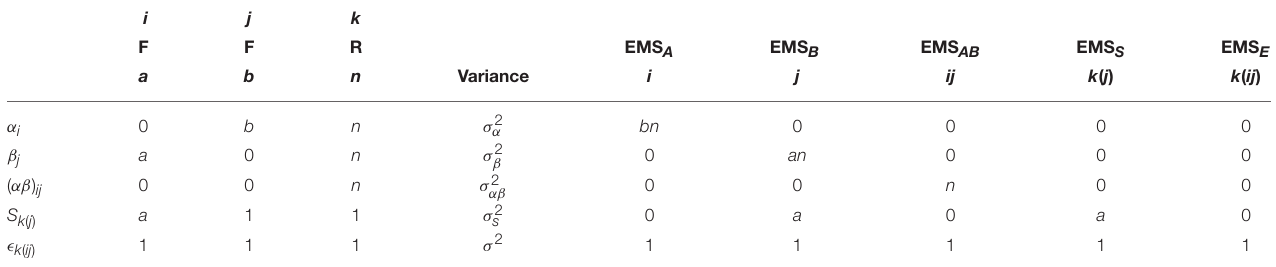
TABLE 3 | Arithmetic for the derivation of the EMS in a 2-way mixed ANOVA with a single within-subject and a single between-subjects factor.